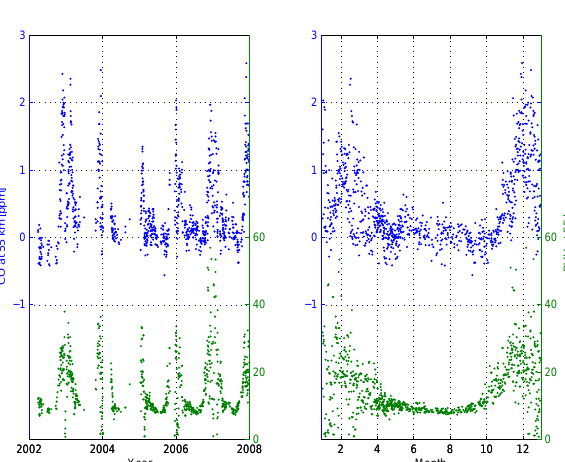
Fig. 7. CO volume mixing ratio and PV above OSO at 55km alti- tude. To the left: the time series 2002–2008. To the right: the data from the different years stacked together. The modified Ertel’s PV is used and 1PVU=10 − 6 K m 2 s − 1 kg − 1 . The overall correlation between CO and PV is